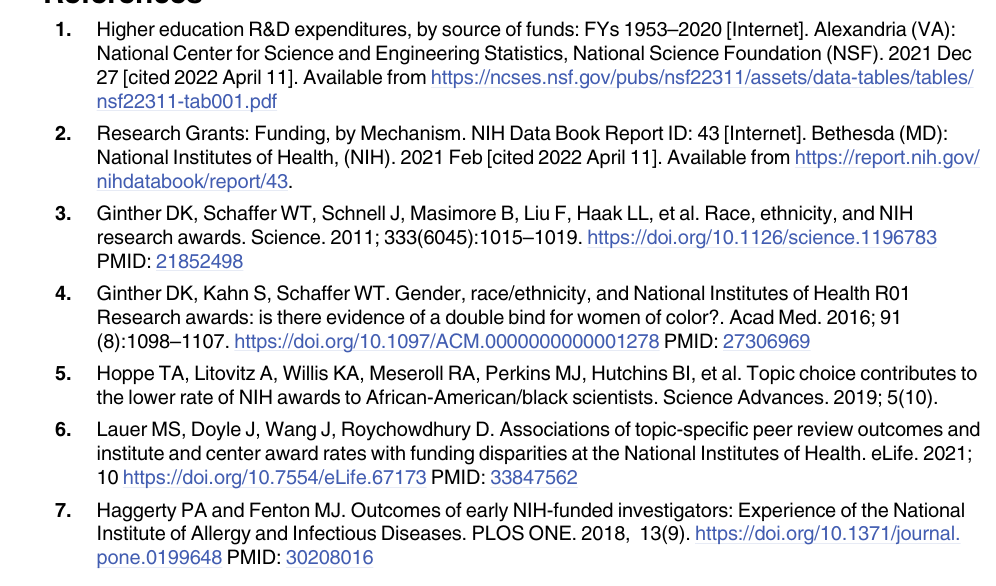
S7 Table. Comparison of submission and award rates. The award and submission ratios for each racial/ethnic group-submission category